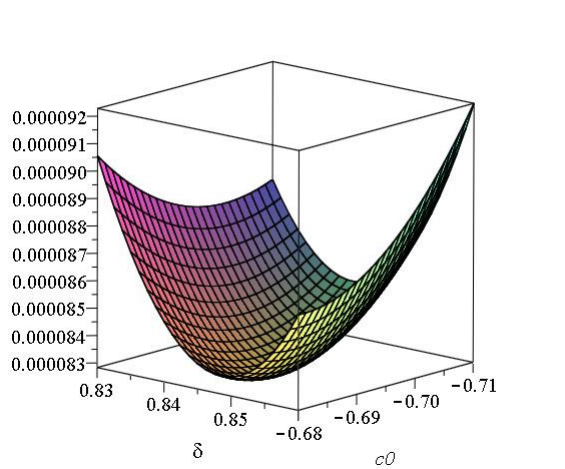
Fig. 4 Plot of E ( c 0 , δ ) , the squared residual error over η ∈ [ 0 , 499 ] as a function of c 0 and δ using parameter values Le = 2, Nb = 2, Pr = 7, Nt = 0 . 5, n = 0 . 8, A = 0 . 24764. The error function has minimum E ( c 0 , δ , A ) = 8 . 28 × 10 − 5 where c 0 = − 0 . 690605 and δ = 0 .